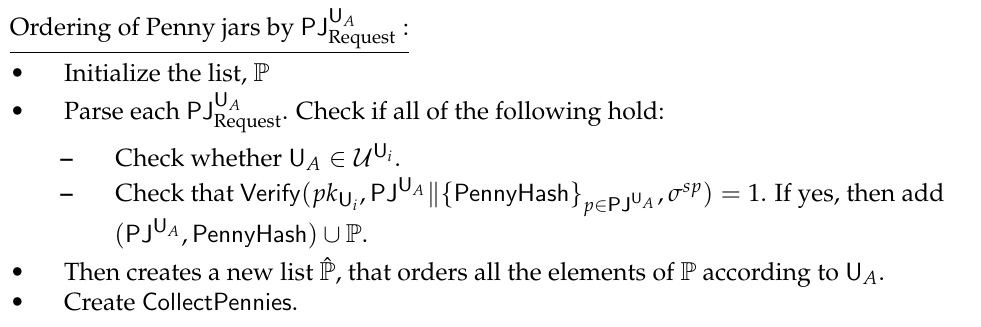
Figure A8. Ordering of penny jars PJ U A